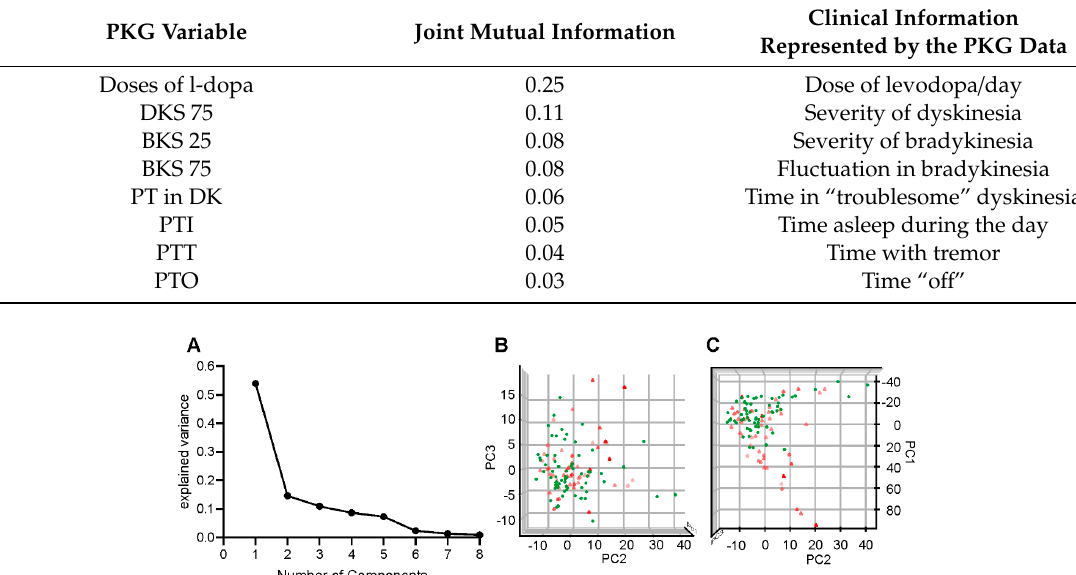
Sensors 2019 , 19 , x FOR PEER REVIEW 7 of 19